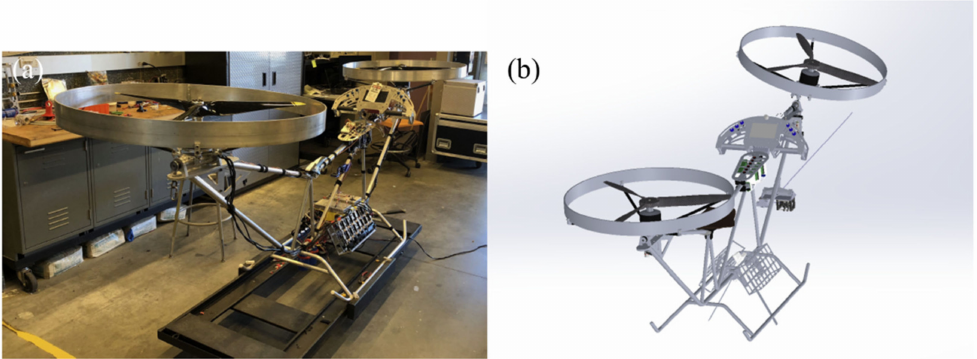
Figure 7. ( a ) Real shot of hoverbike; ( b ) 3D model of